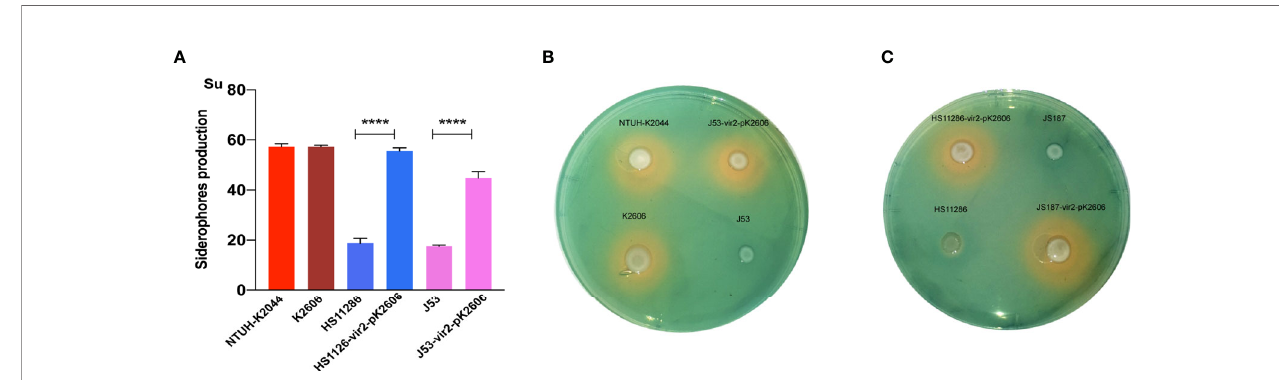
FIGURE 3 | The siderophore production of strains and transconjugants. (A) The quantitative siderophore production of K2606, HS11286, J53, HS11286-vir2- pK2606, and J53-vir2-pK2606. An unpaired two-sided Student ’ s t-test was performed for parental strain and its transconjugant. Each data point was repeated three times (n = 3). Data are presented as the mean ± s.e.m. ****P < 0.0001. (B, C) The CAS agar plate assay indicated the siderophore production. Siderophore production was evaluated by the